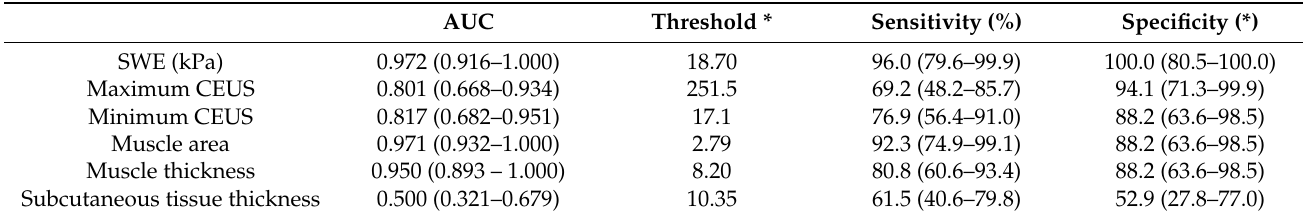
Table 4. Diagnosis values of the QRF muscle